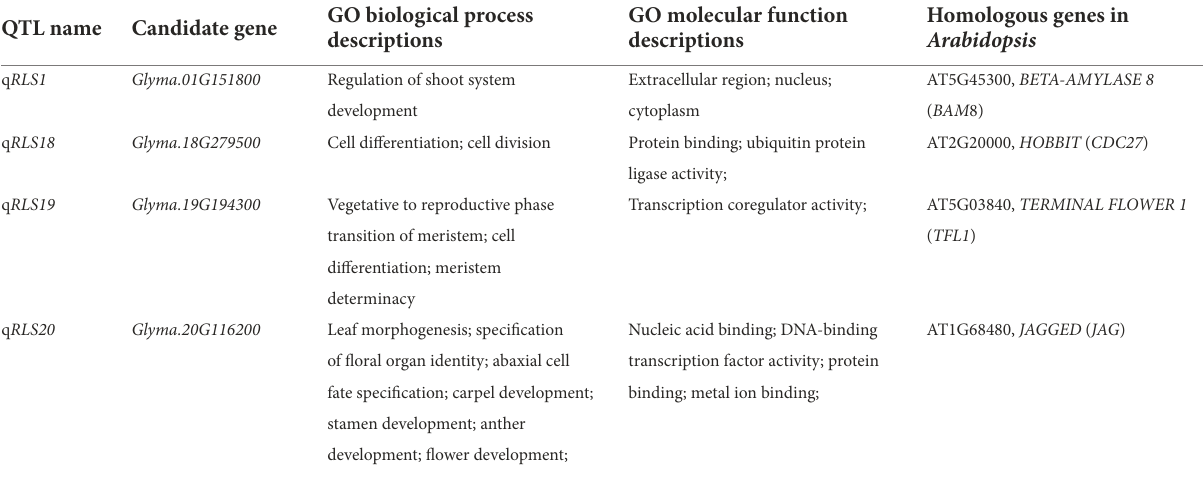
TABLE 3 Candidate genes for heterophylly in